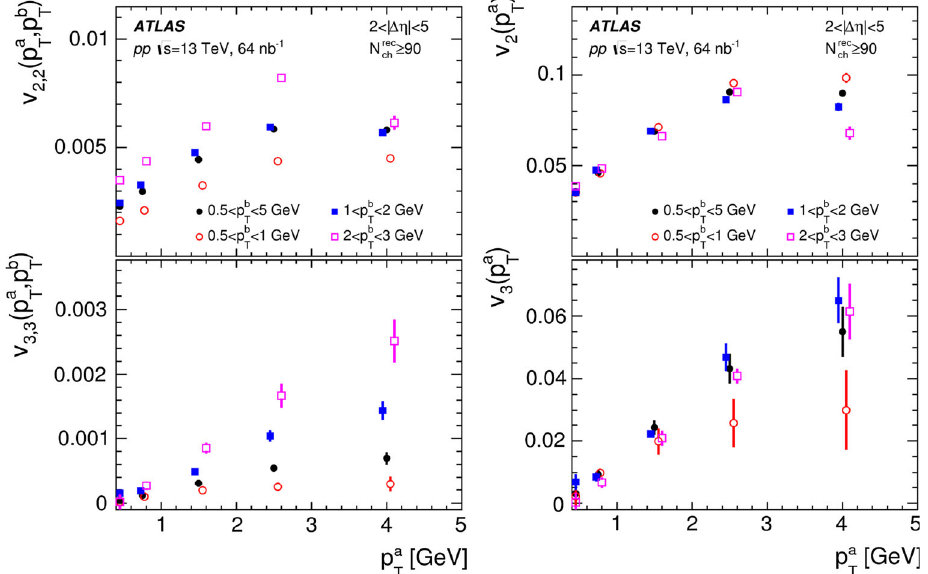
Fig. 12 Experimental data for v nn and v n versus p T at W = 13TeV